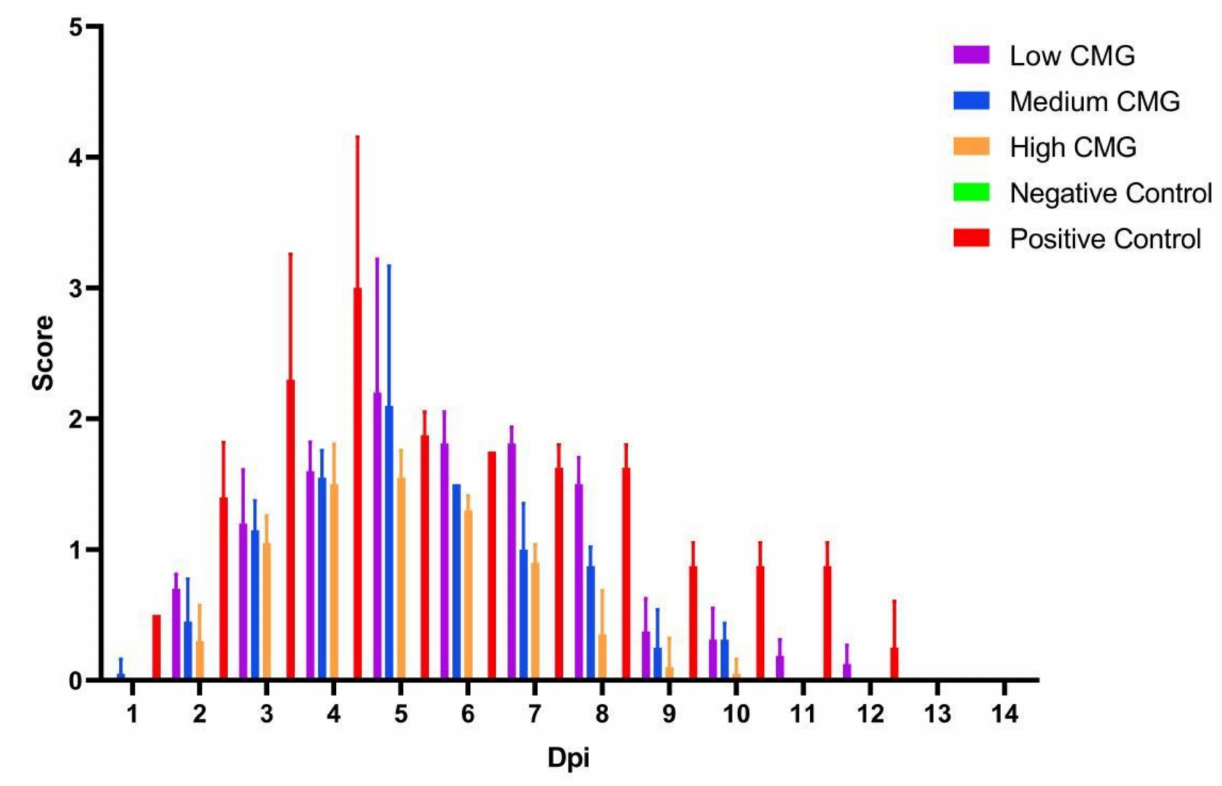
Figure 3. The clinical signs’ scores. Clinical signs, including parameters such as loss of appetite, respiratory distress, fever, and behavioral lethargy. Clinical parameters were scored using values 0–2 (none = 0; mild = 1; severe = 2), while survival was recorded in the same way with values 0–1 (survived = 0; died = 1). Based on the recorded parameters, the clinical score (CS) was calcu- lated with the formula: CS = {[(numeric value of anorexia + numeric value of respiratory clinical signs + numeric value of fever + numeric value of lassitude)/4] + 4 × (numeric value of survival)}. The final average score of the five piglets in each group was taken. The more severe the clinical signs of the piglet, the higher the score.